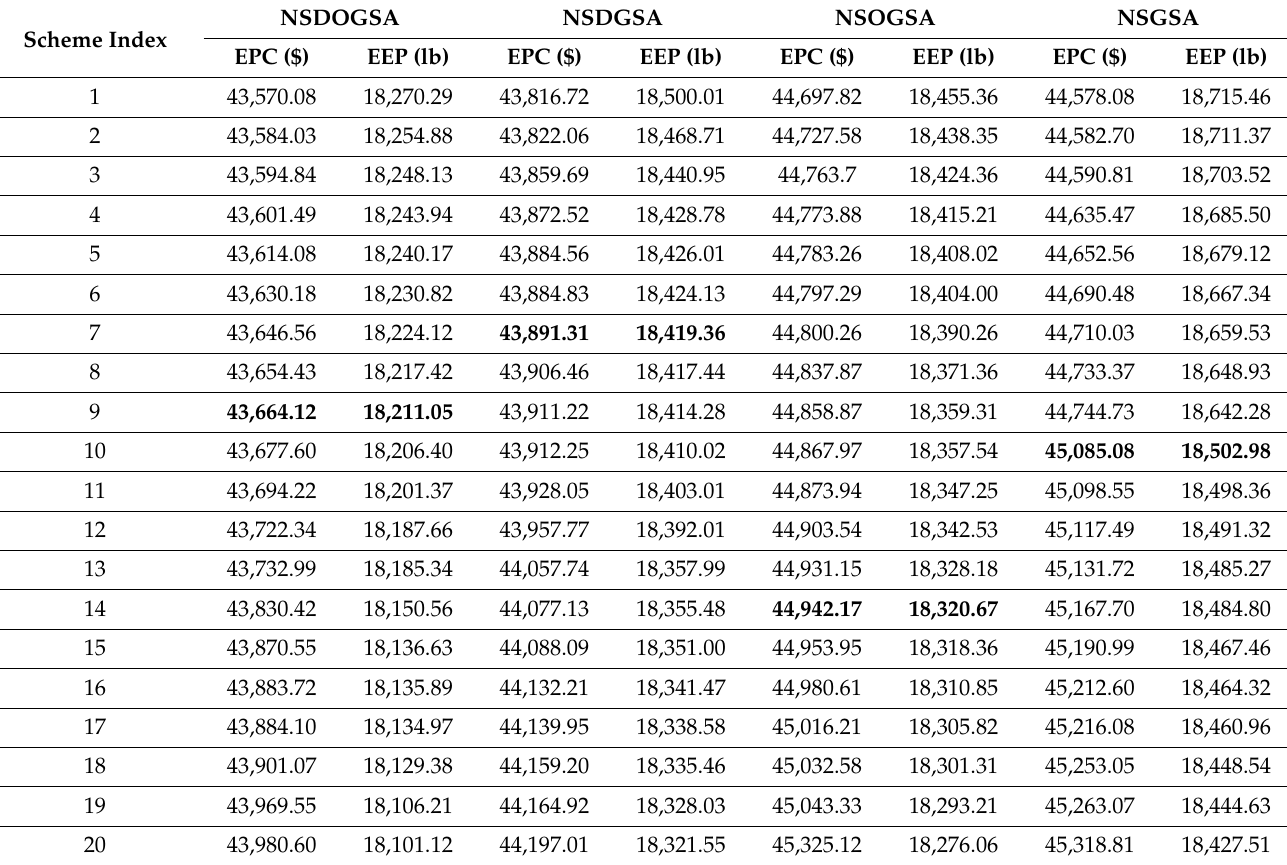
Table 9. NS results attained with various techniques for MSHTS of Test system-II.